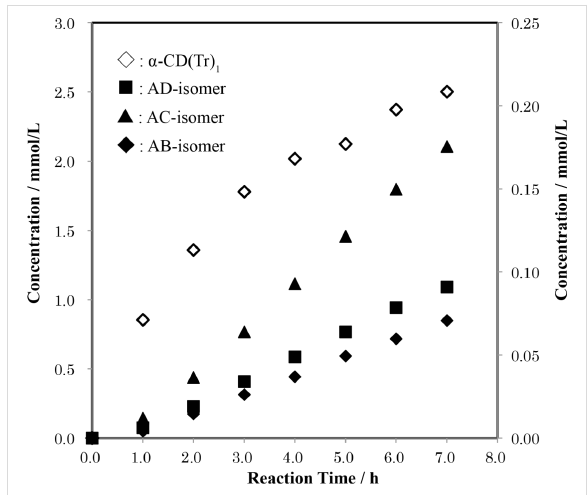
Figure 5: Time-course of the formation of mono- (left ordinate) and di-6- O -tritylates (right ordinate) of α -CD in a reaction of α -CD with TrCl in pyridine at 55 °C. Average mole ratio of AB:AC:AD = 0.40 ± 0.01:1.00:0.52 ± 0.02.